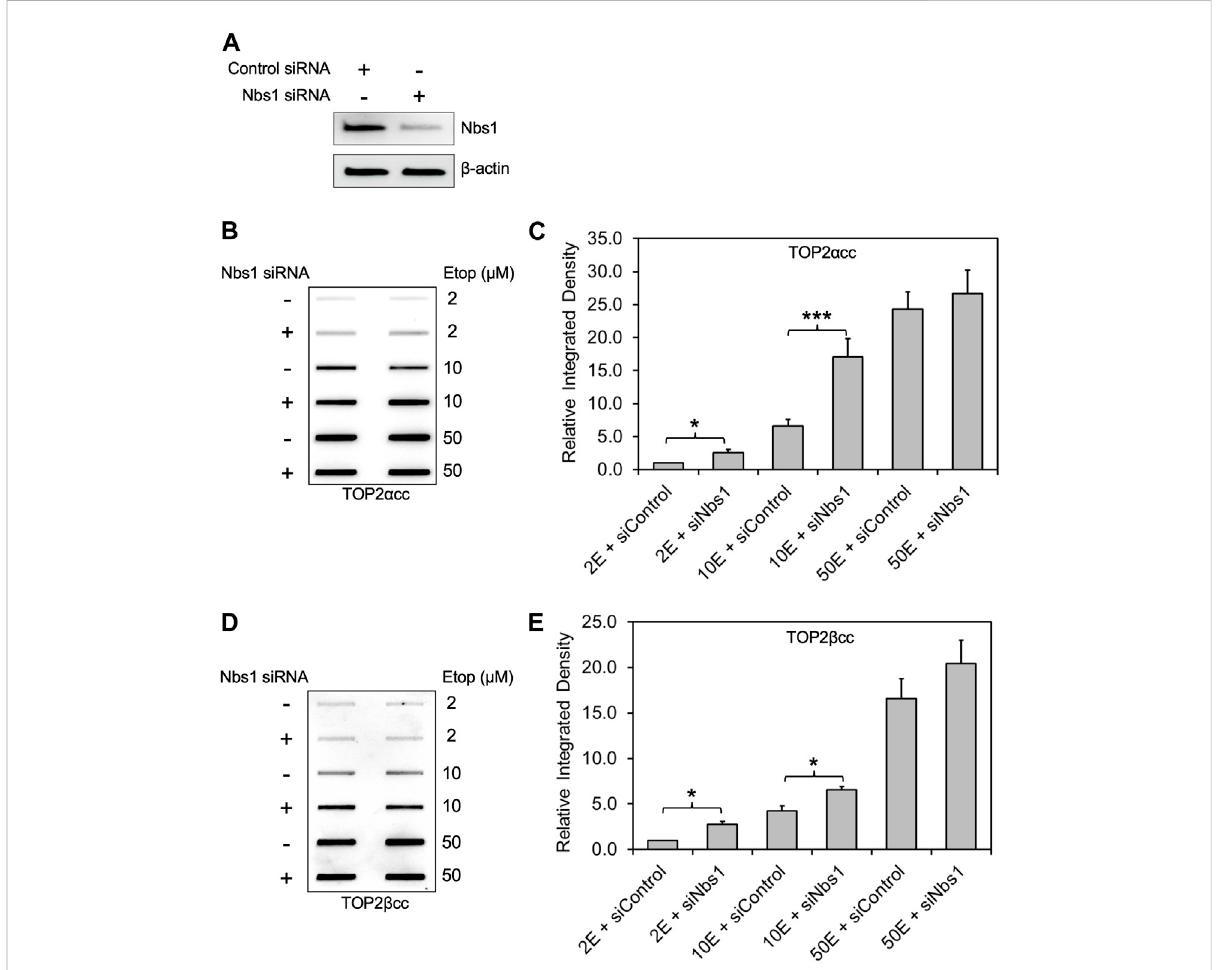
FIGURE 2 KnockdownofNBS1bysiRNAincreasesthelevelofetoposide-inducedTOP2-DNAcomplexes.Experimentalconditionsandmethodswerethe sameasFigure1. (A) WesternblotassessingNBS1levelsusingantibodyagainstNBS1.Semi-quantitativeimageanalysisofimmunoblotsusingImageJ indicatedthattreatmentwithsiNbs1resultedin85%knockdownofendogenousNBS1(quantitationnotshown). β -actinwasusedasaproteinloading control. (B) ICEassayillustratingTOP2 α ccinNBS1knockdowncells.Thepanelillustratesarepresentativeassay. (C) Densitometricanalysisofall experimentscomparingrelativeintegrateddensitiesofTOP2 α ccsignalamongstNBS1knockdownandcontrolcellstreatedwith2 μ M,10and50 μ M etoposide. Integrated density of TOP2 α cc signal of each group was normalized to that of control cells treated with 2 μ M etoposide. * denotes p -value < 0.05. Samples not marked with a bar did not result in a statistically signi fi cant difference. (D) ICE assay illustrating TOP2 β cc. The panel illustrates a representative assay. (E) Densitometric analysis of all experiments comparing relative integrated densities of TOP2 β cc signal amongst MRE11 knockdown and control